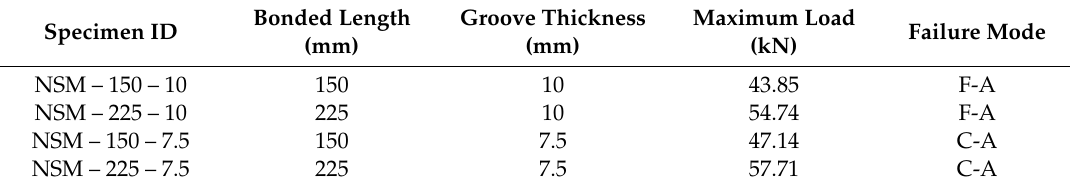
Table 2. Characteristics of the